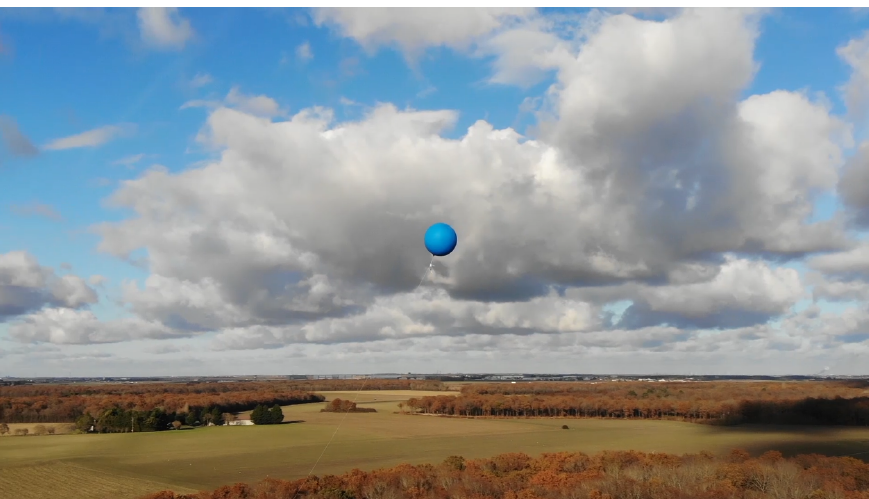
Figure 11. One out of 11 balloons carrying a